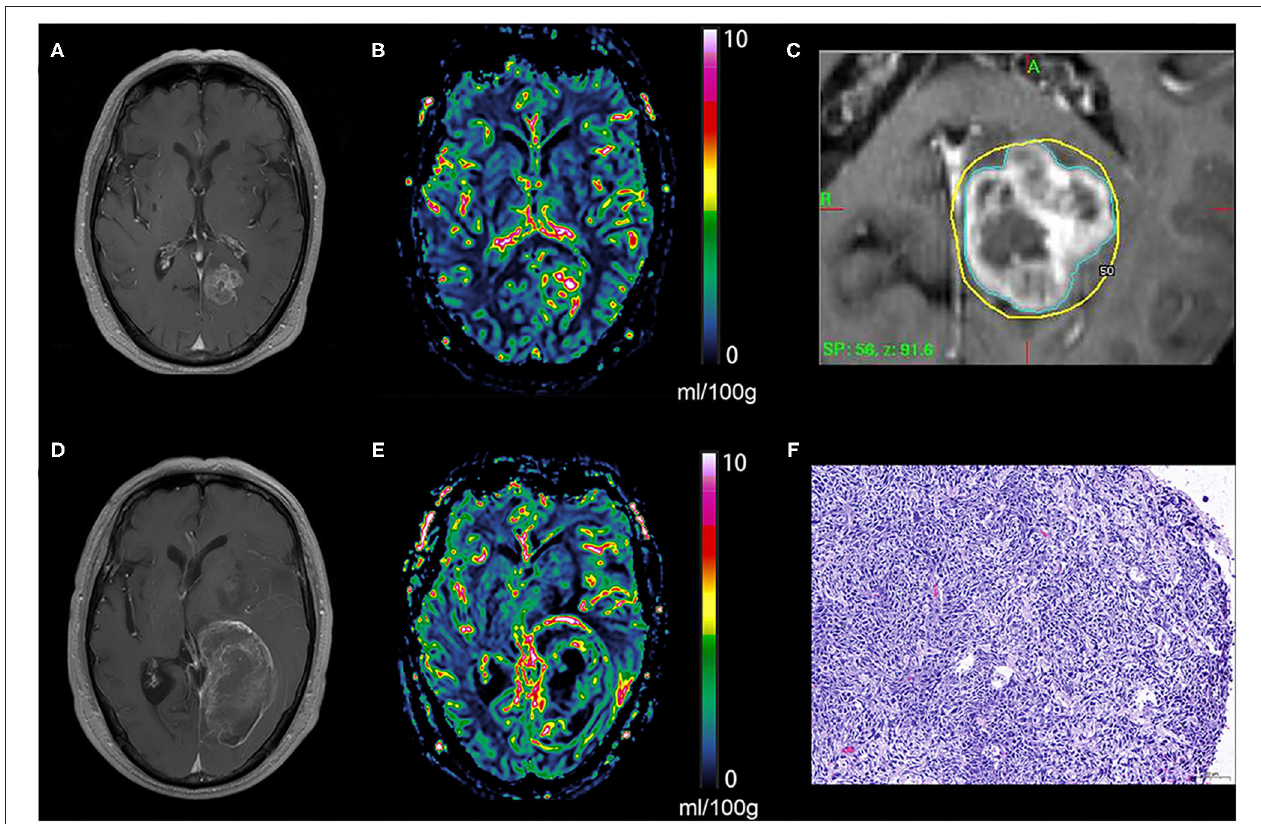
FIGURE 2 | Tumor recurrence of the hyperperfusion BM. An enhancing lesion was discovered in the left occipital lobe of a 69-year-old patient with lung cancer (A) , a quantitative CBV map revealed that the lesion was hyperperfused (B) , and gamma knife radiosurgery was performed later (C) . One year later, the enhancing lesion was enlarged (D) , and a quantitative CBV map revealed that the enlarged lesion was still hyperperfused (E) . The lesion was removed via surgical operation, and the pathological result was brain metastasis recurrence (F) . BM, brain metastases; CBV, cerebral blood